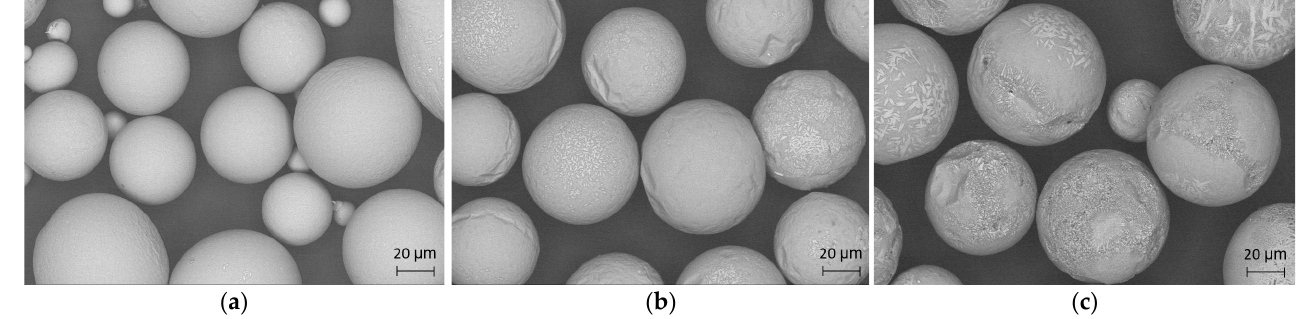
Figure 2. Surface morphology of the resulting powder in the size range of 75–45 μ m atomized at the same speed of 40,000 rpm using different gas compositions: ( a ) He; ( b ) He-Ar; ( c ) Ar. Micrographs of centrifugally atomized particle sizes synthesized in a He atmosphere are shown in Figure 3. Figure 3a shows the cross-section micrograph of the 45–20 μ m